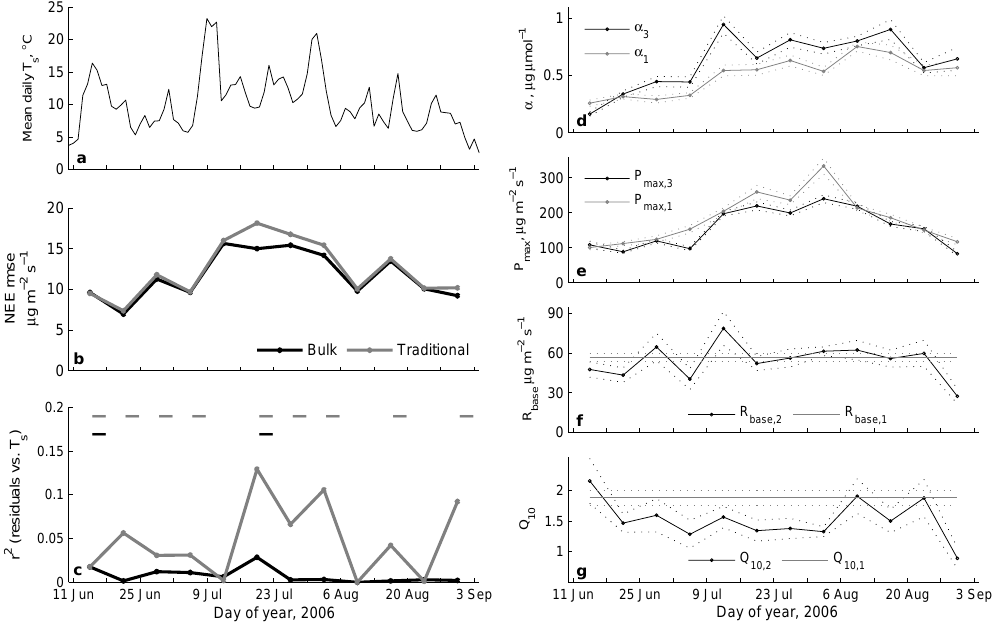
Fig. 2. (a) A time series of mean daily surface temperature is shown for comparative purposes. Time series of fitting statistics include (b) root mean square error (rmse) between the NEE data and models and (c) coefficient of determination ( r 2 ) between NEE model residuals and surface temperature ( T s ). The sign of this correlation (when significant, with p < 0 . 05) is given above each time interval. For example, residuals of the traditional model (in grey) are negatively correlated to temperature between 11 June and 9 July 2006; in these time periods the model would overpredict CO 2 fluxes at higher temperatures. Time series of NEE parameters from the new, weekly fit bulk method (in black) and the traditional method (in grey) through the measurement period are presented with parameter confidence intervals shown in dotted lines. These parameters are the initial quantum efficiency α (d) , maximum canopy photosynthetic potential P max (e) , basal respiration R base (f) , and respiration sensitivity term Q 10 (g) .